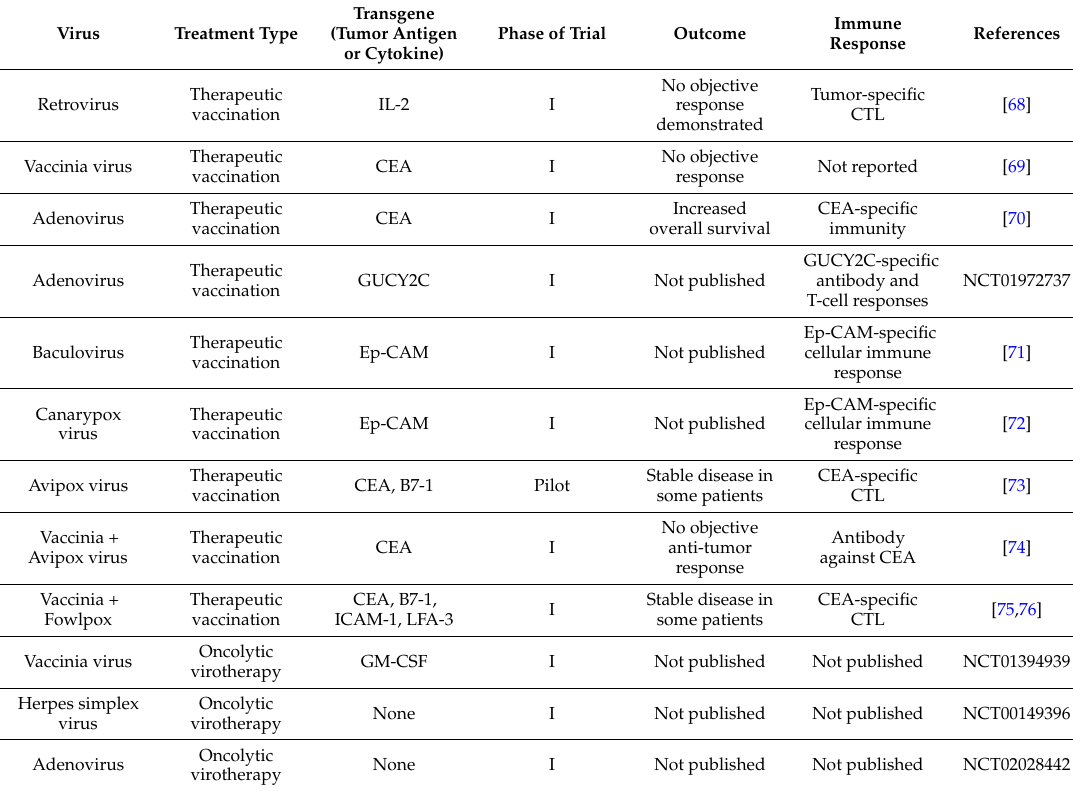
Table 1. Clinical trials that are using viruses as direct vaccines or as vectors in the preparation of autologous cell-based